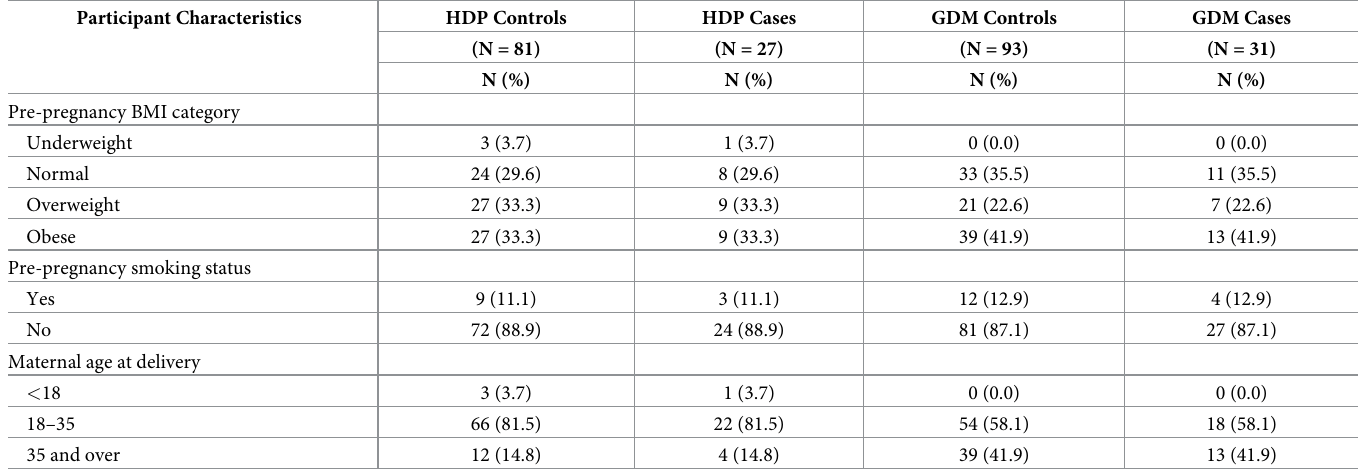
Table 1. Summary of characteristics that matched those with HDP or GDM to their respective control groups. Participant